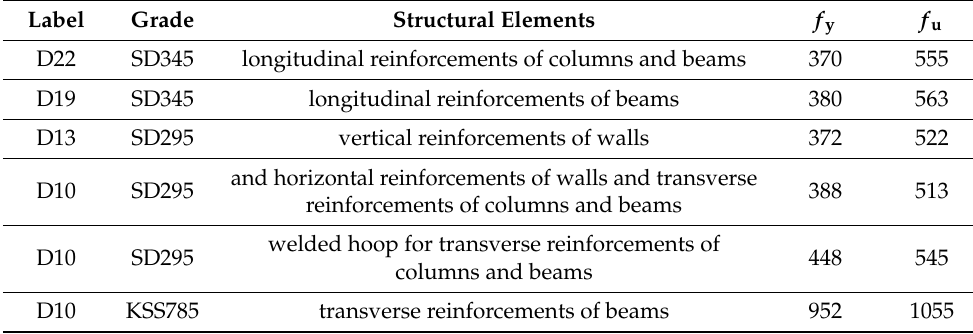
Table 5. Material properties of reinforcement bar (Unit: